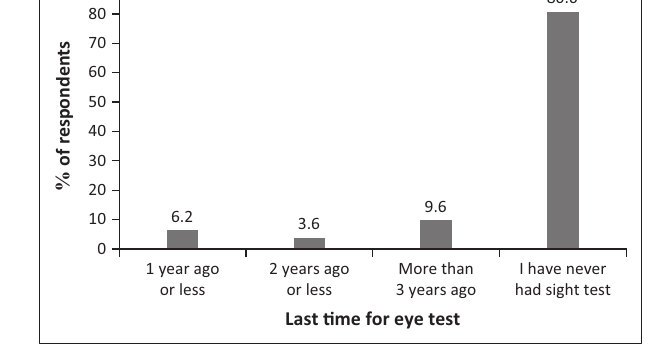
FIGURE 5: When was your last eye test?